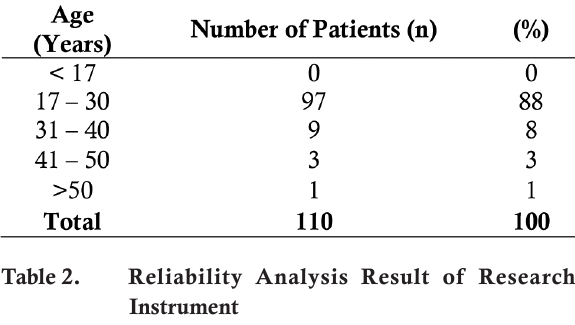
Table1. Distribution Frequency of Patient’s Age